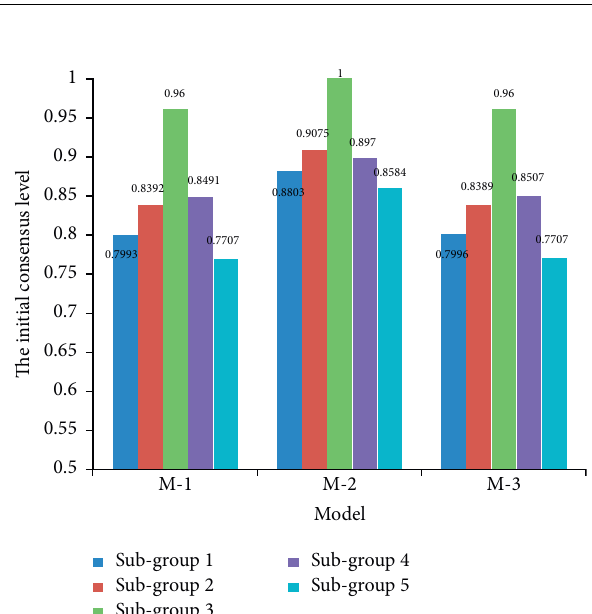
Figure 2: .e changes of the subgroups’ consensus level. Note: M- 1: the proposed consensus model, M-2: without considering the interactive weights, and M-3: without the experts’